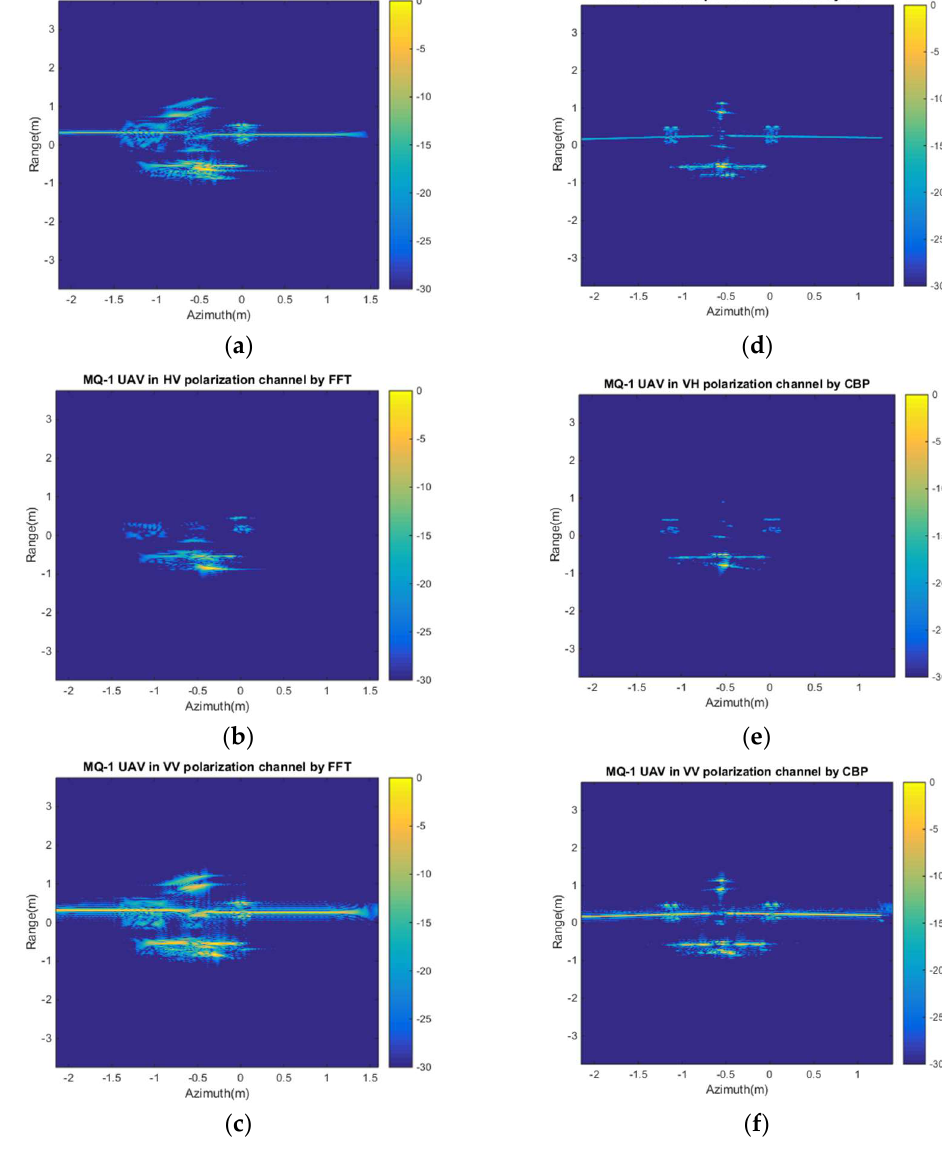
Figure 6. The full-polarization imaging results of “MQ-1” UAV with FFT and CBP algorithm. ( a )”MQ-1” in HH polarization by FFT; ( b ) “MQ-1” in HV polarization by FFT; ( c ) “MQ-1” in VV polarization by FFT; ( d ) “MQ-1” in HH polarization by CBP; ( e ) “MQ-1” in HV polarization by CBP; ( f ) “MQ-1” in VV polarization by CBP.